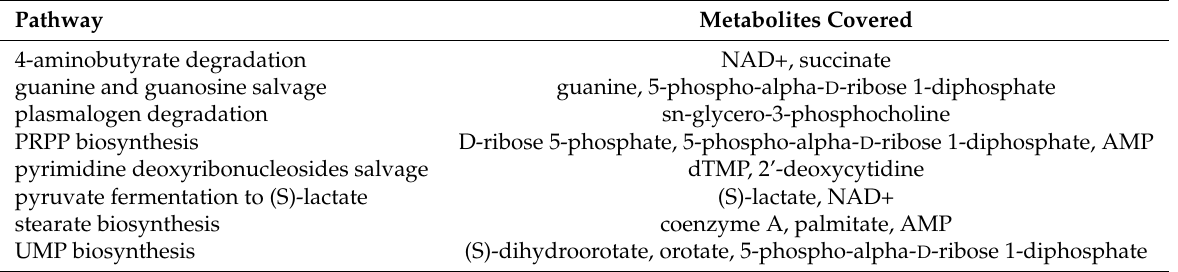
Table A11. McDonnell 2013, Pathway Covering Using Pathway Size Cost Function.